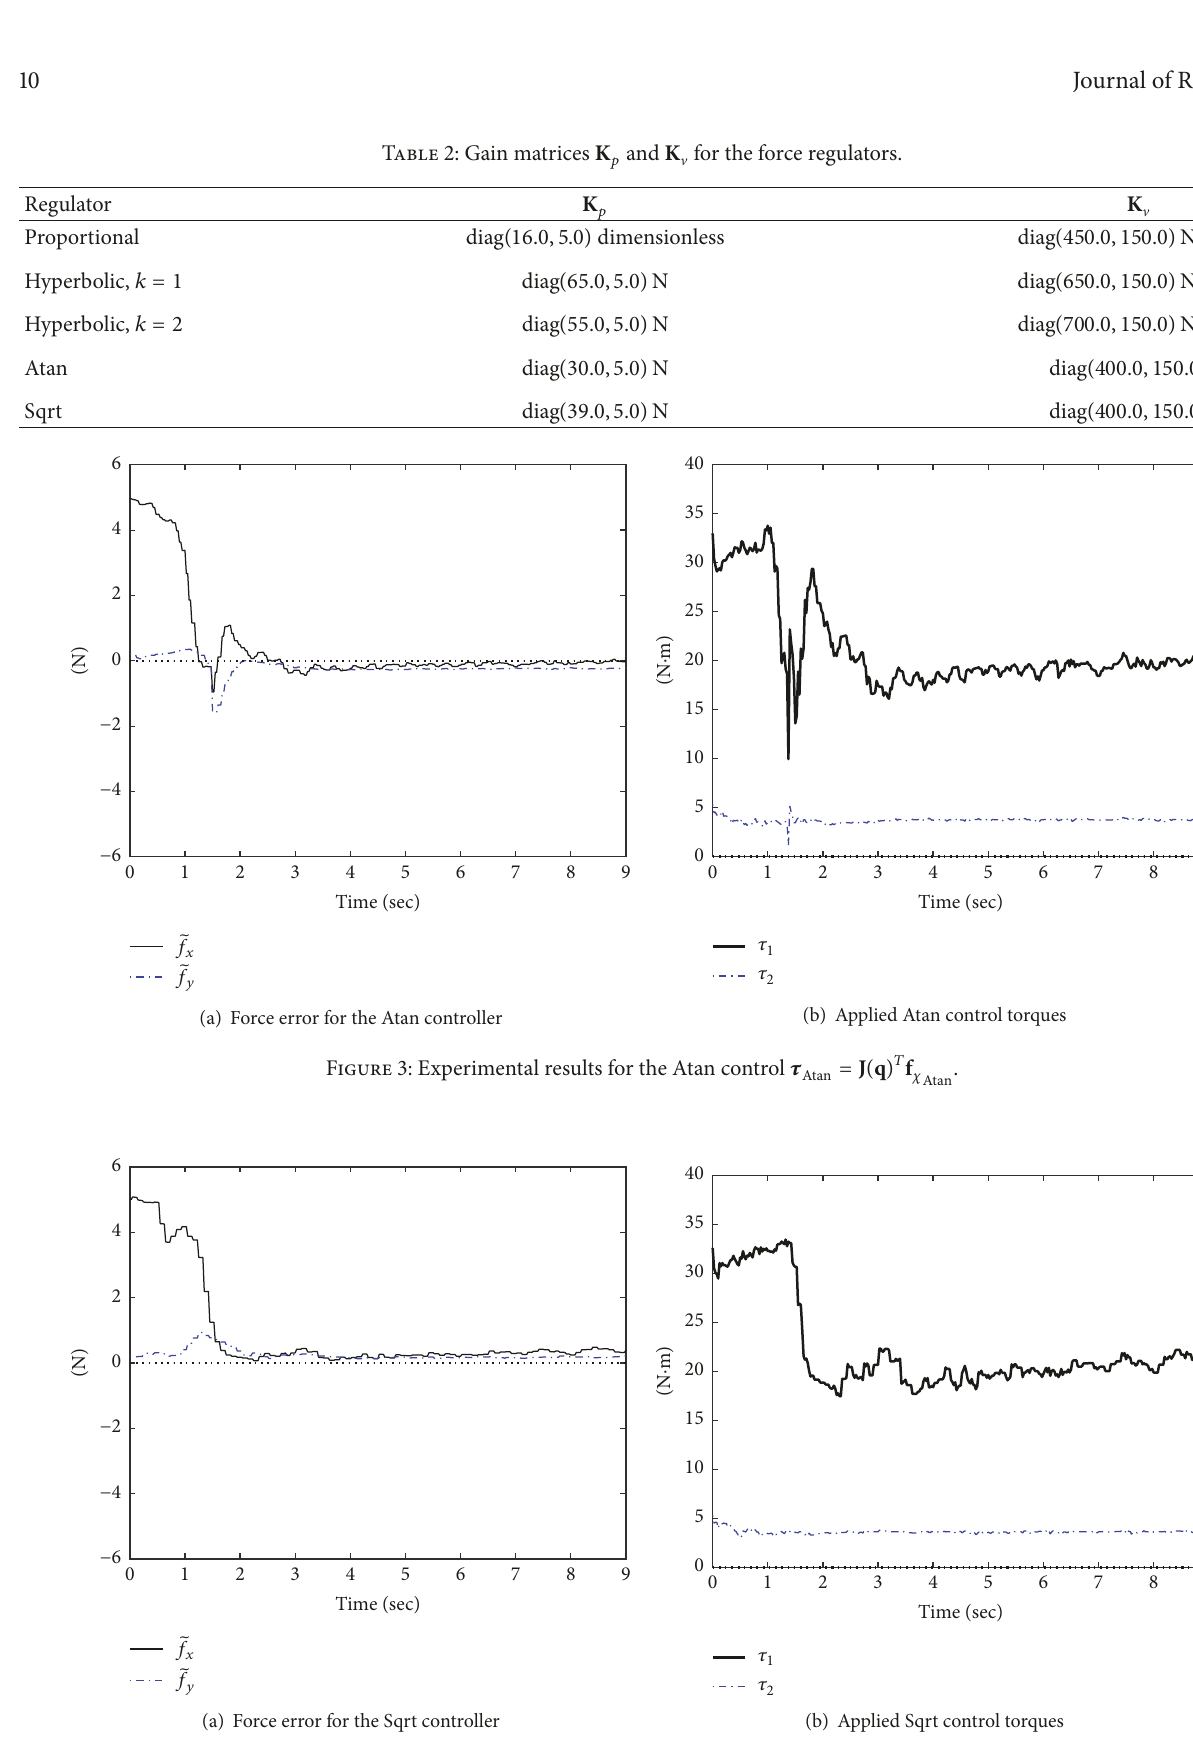
Figure 4: Experimental results for the Sqrt control 𝜏 Sqrt = J ( q ) 𝑇 f 𝜒